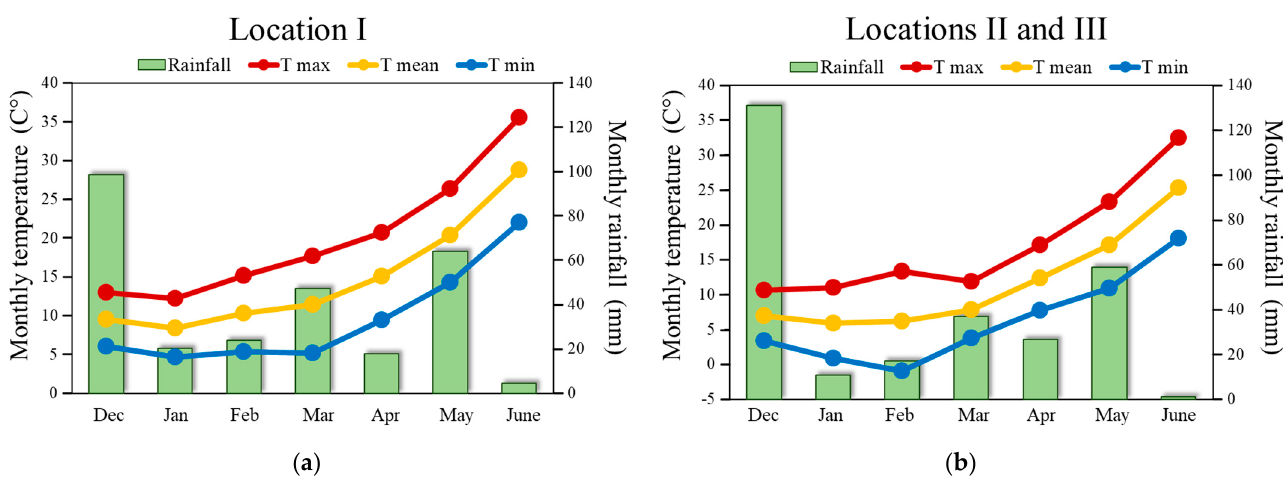
Figure 3. Climatic trends during the experimental period (December 2021–June 2022) at location I ( a ) and locations II and III ( b ), sited in Central Sicily